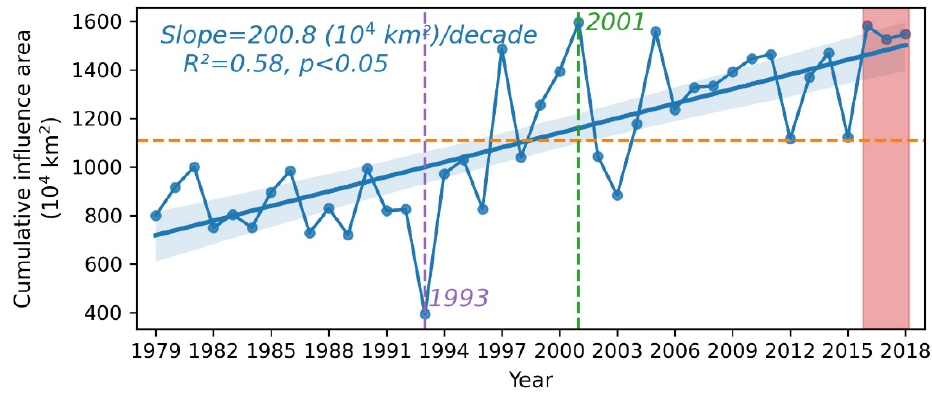
Figure 10. Duration variations in cumulative influence area (CIA) of heatwave events in the 1979–2018 period across China. The orange dashed line denotes the mean CIA of heatwave events during the study period; the shadowed area in blue represents a 95% confidence interval for the fitting line of all CIAs, while the shadow in red shows the period of relatively higher durations in recent years; the vertical line in purple and green are the minimum and maximum year of CIA, respectively.